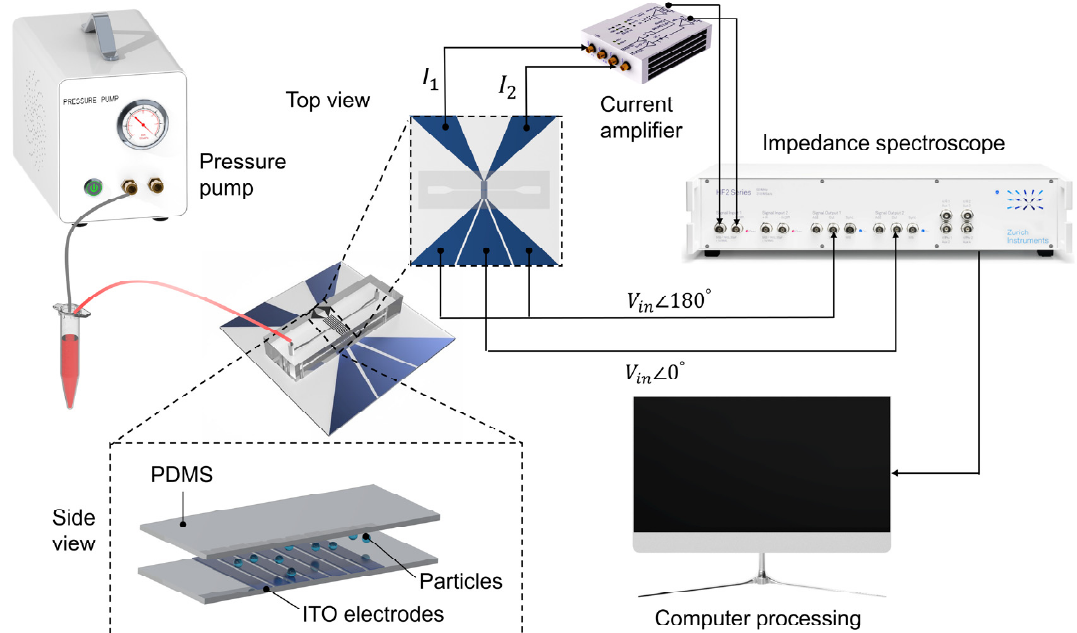
Figure 3. Schematic of the double differential microfluidic impedance cytometer setup consisting of a PDMS microchannel and ITO electrodes. A pressure pump injected particles into the PDMS microchannel. AC voltage signals generated by impedance spectroscope were applied to the detecting electrodes. A current amplifier was used to obtain the differential current signal, which is fed to the impedance spectroscope. Eventually, the signal is transmitted to a computer for